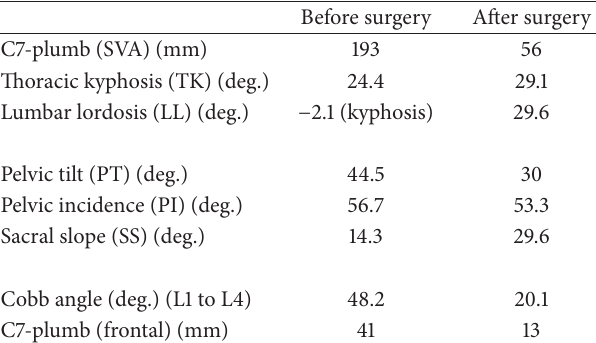
Table 1: Radiographic parameter (Case1). Before surgery After